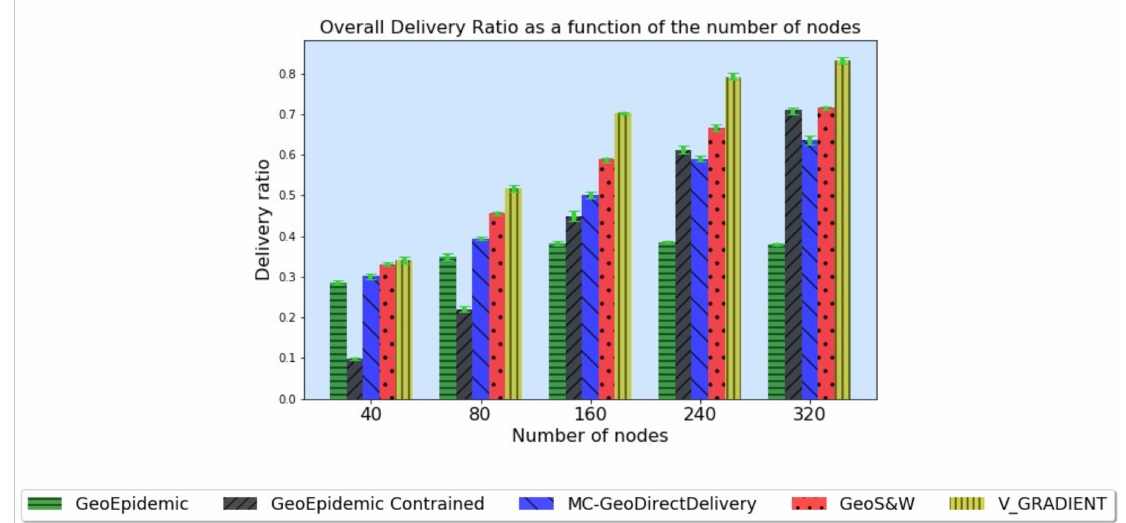
Figure 7. Delivery ratio as a function of node density and